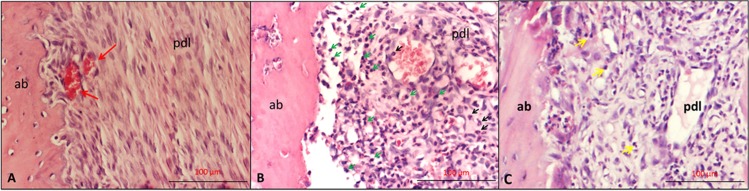
The histological representive images of each experimental group.A- The histological images of NL group showing normal periodontium (red arrows: erythrocytes). B- LO group showing intense inflammatory cells (green arrow: lymphocyte, black arrow: neutrophils) and dilated blood vessels C- The histological images of H group showing moderate inflammatory cell infiltrate in periodontal ligament (Yellow arrows show inflammatory cells). (ab: alveolar bone, pdl: periodontal ligament).